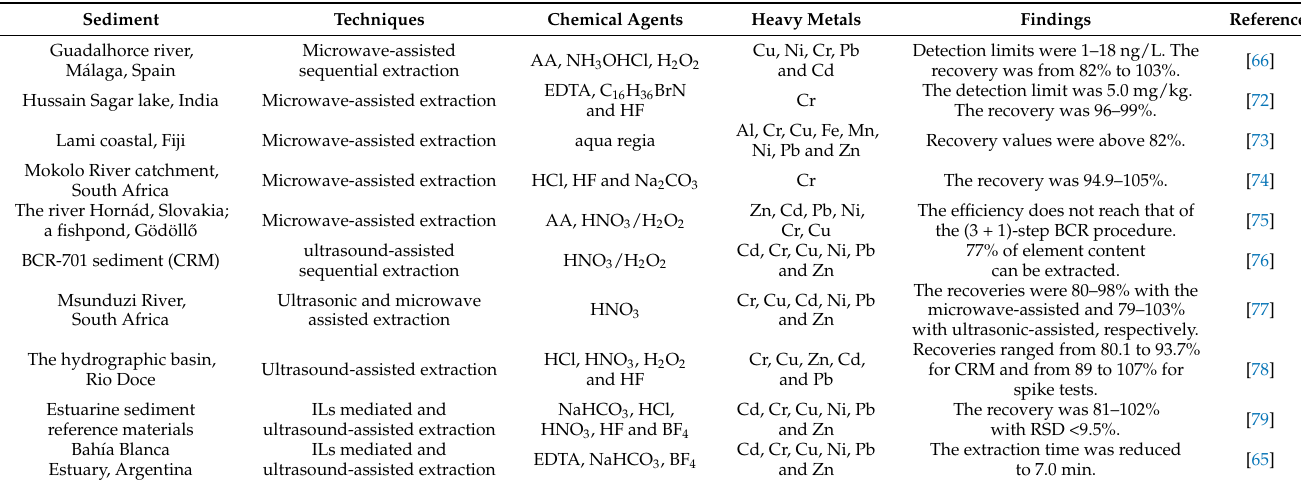
Table 3. Chemical extraction for heavy metal contaminated sediment in recent